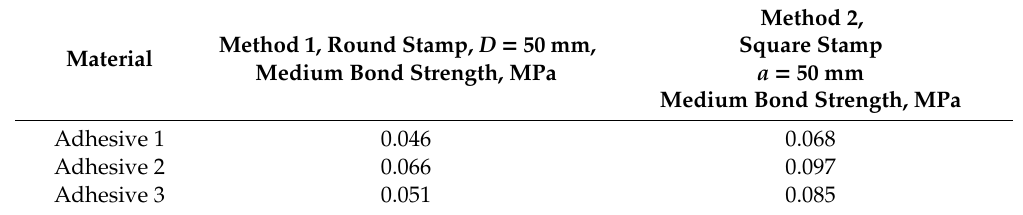
Table 5. Medium bond strengths obtained according to ÖNORM (round stamp) and ETAG 004 (square